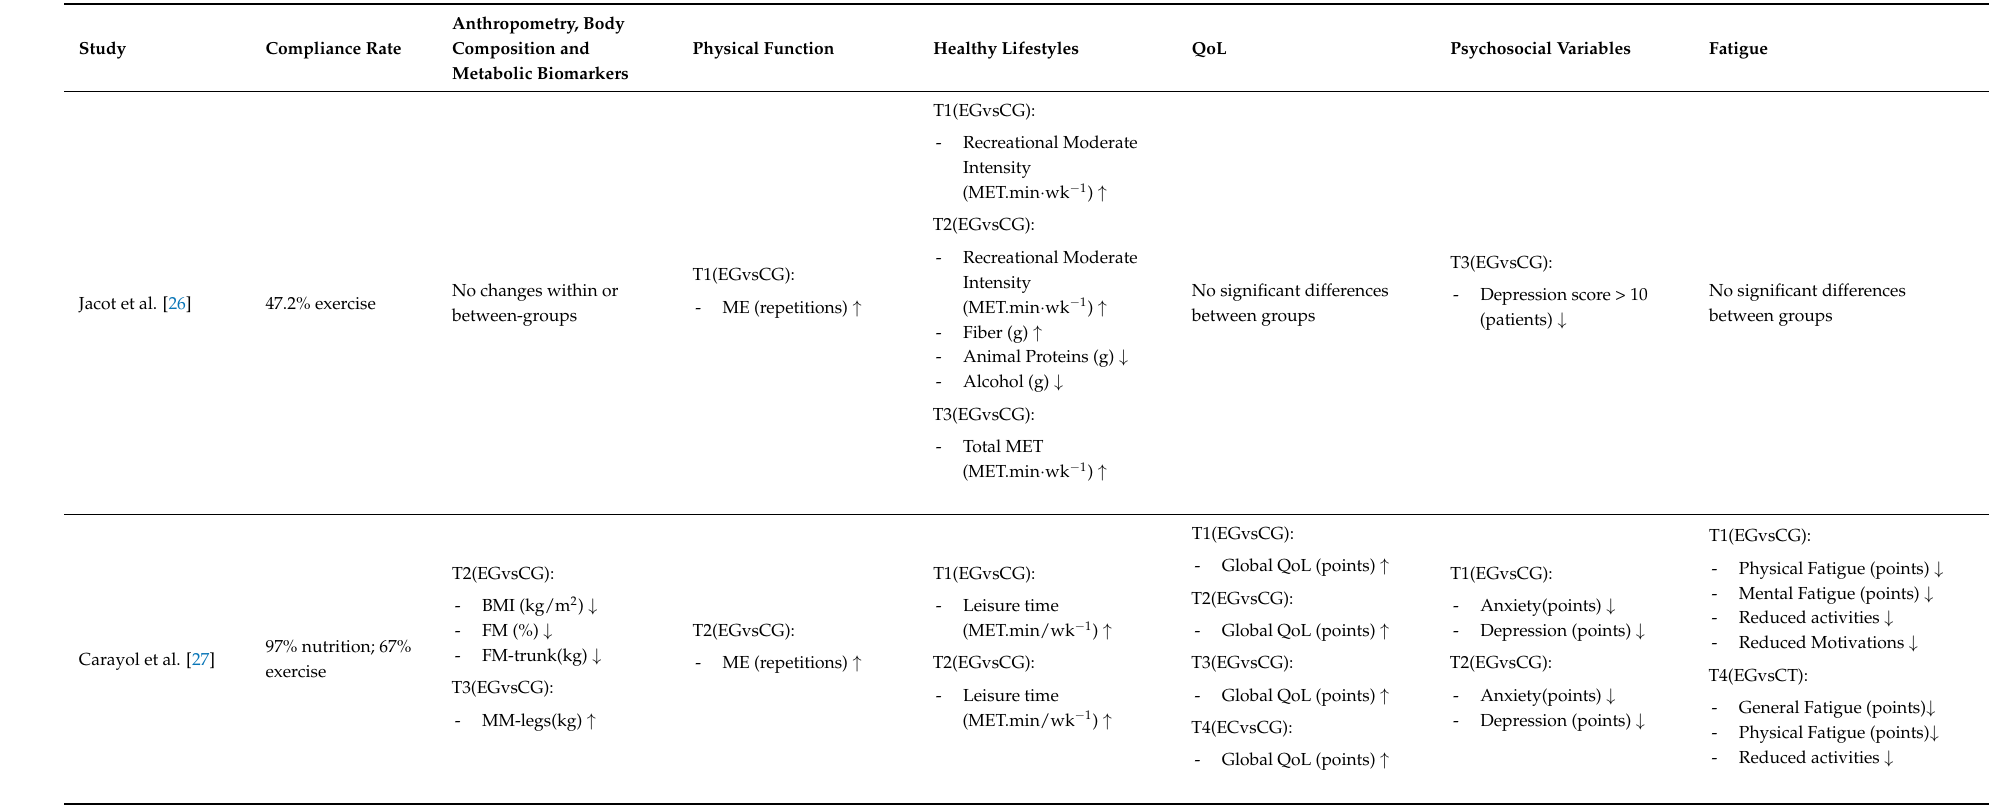
Table 4. Results of studies with exercise plus diet